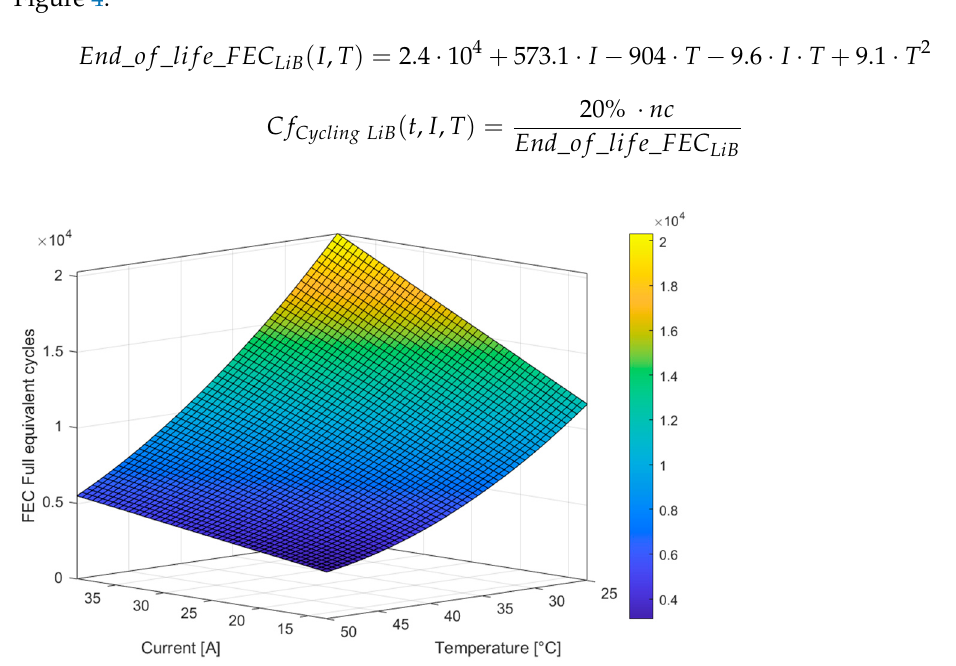
Figure 4. Full equivalent cycles (FEC) of LiB to drop to 80% of beginning-of-life capacity.